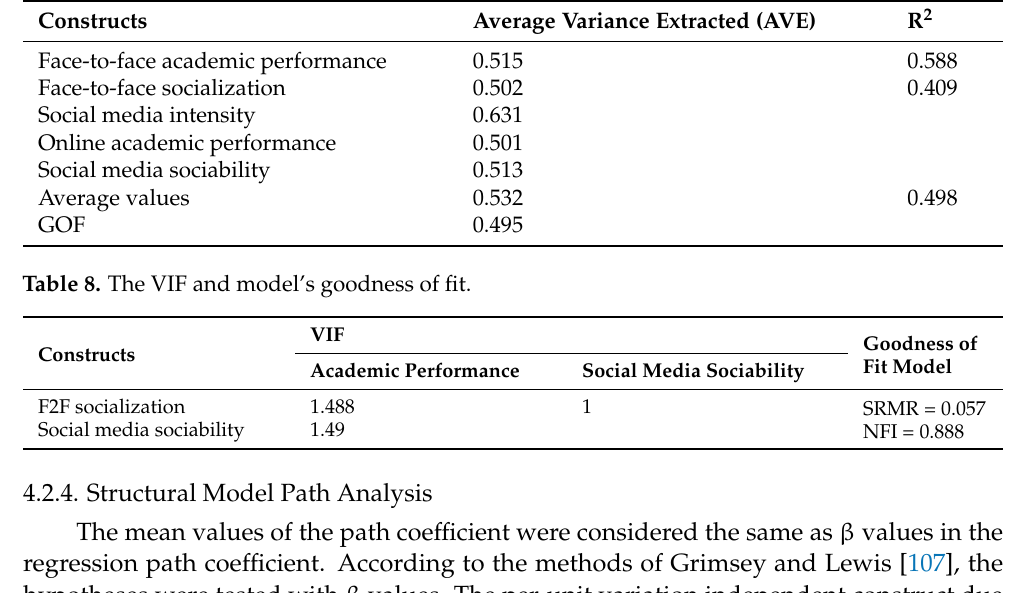
Table 7. The Goodness of fit index.